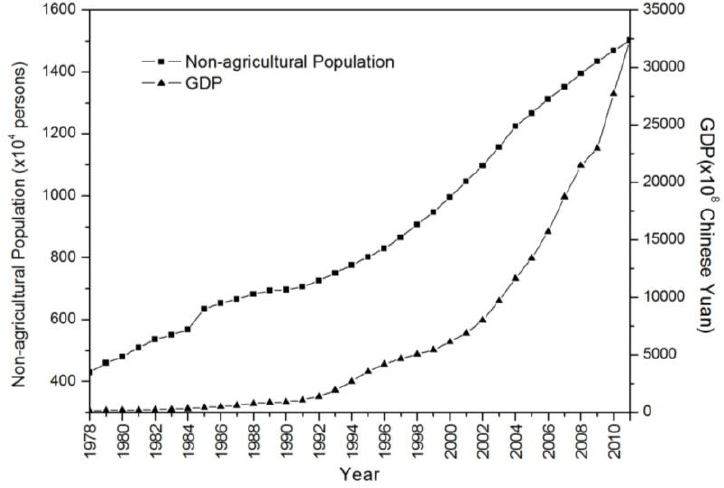
Figure 2. Changes in the non-agricultural population and the GDP from 1978–2011 for Zhejiang